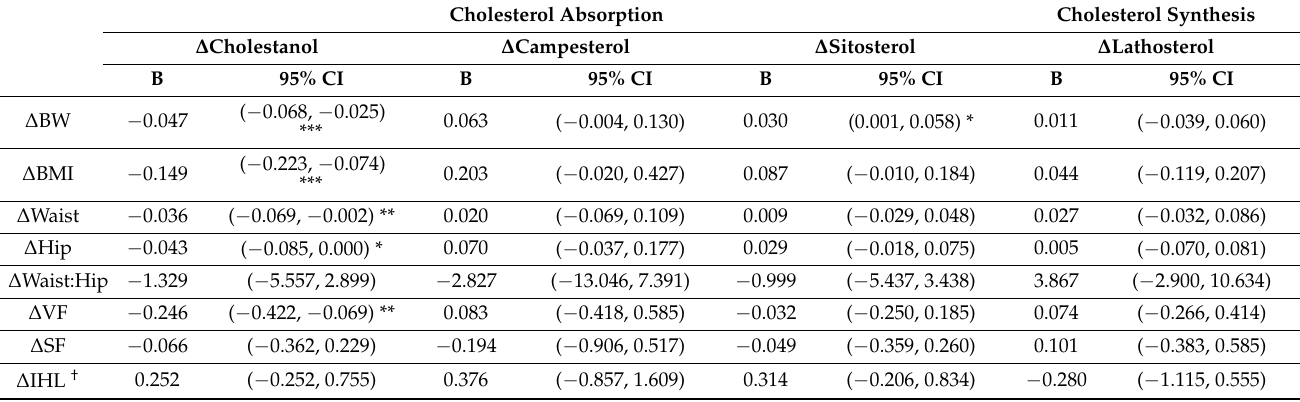
Table 2. Results of linear regression analyses to investigate the relation between changes in cholesterol absorption and synthesis markers with changes in anthropometric measures, fat distribution and IHL after weight loss intervention ( n =